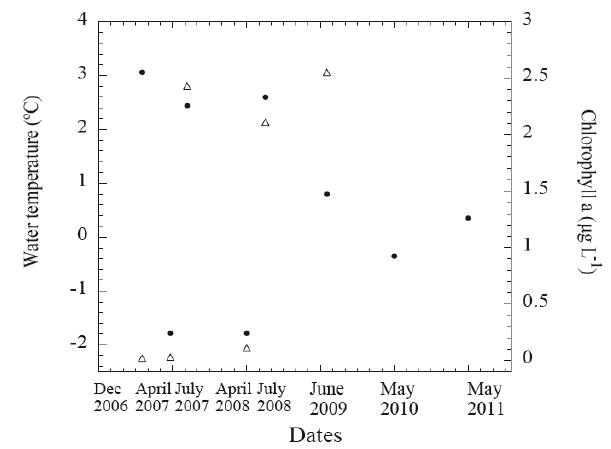
Fig. 2. Mean( ± SE) surface seawater temperature ( ◦ C, circles) and chlorophyll a (µgchl a L − 1 ) concentration (triangles) over